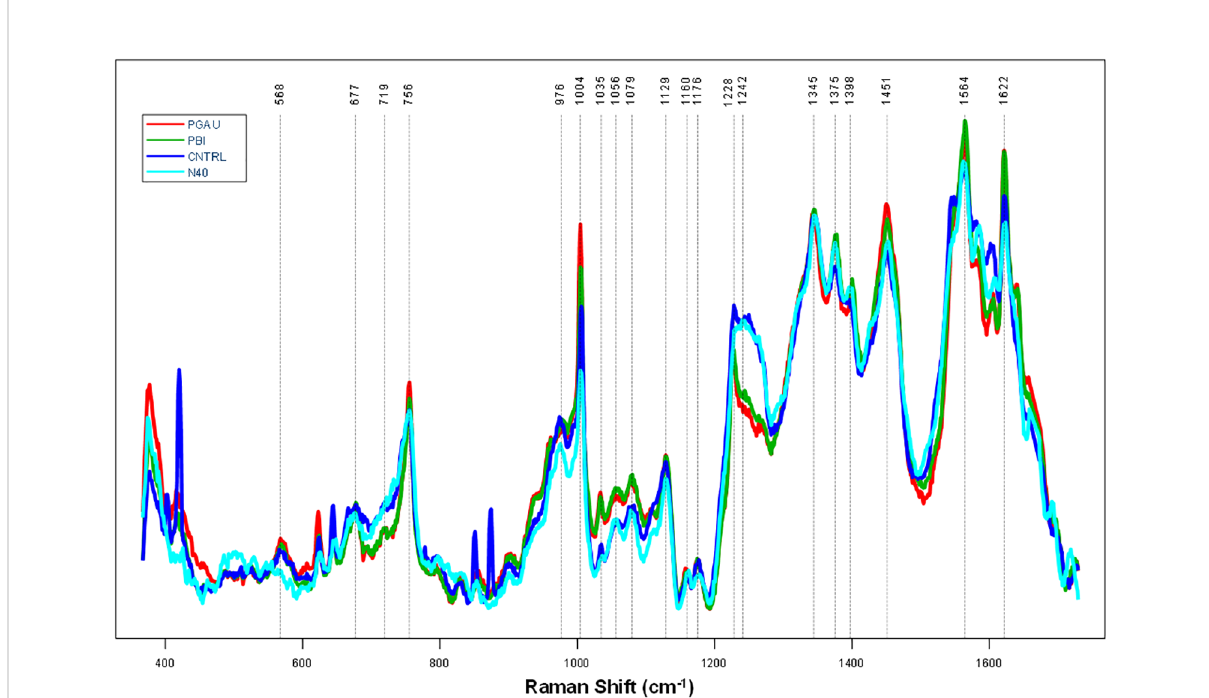
FIGURE 1 The average preprocessed (Automatic Whitaker Filter baselined and area normalized) Raman spectra for blood samples taken from Borreliella -infected C3H mice at day 56 postinfection. C3H mice (5 animals per group) were infected with B afzelii PGau (PGAU), B garinii PBi (PBI), or B burgdorferi N40 (N40). One group of mice remained uninfected and served as a control